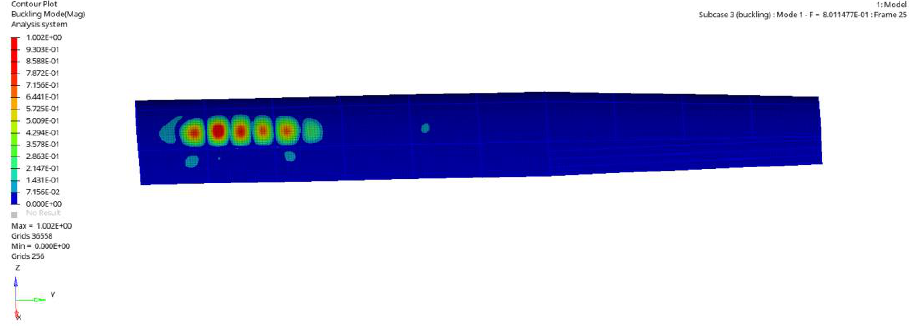
Figure 19. Wing stability analysis ( “ +2.5 G ” in condition A).